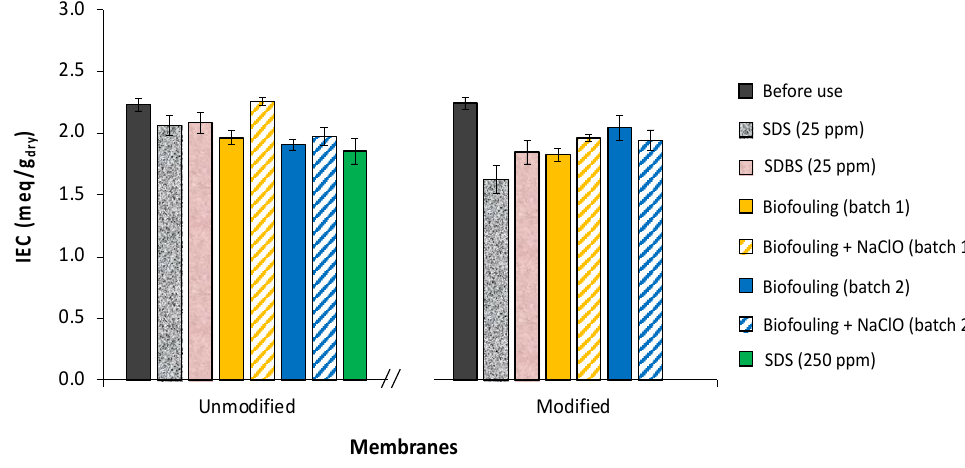
Figure 2. Ion exchange capacity of (bio)fouled membranes in different scenarios.